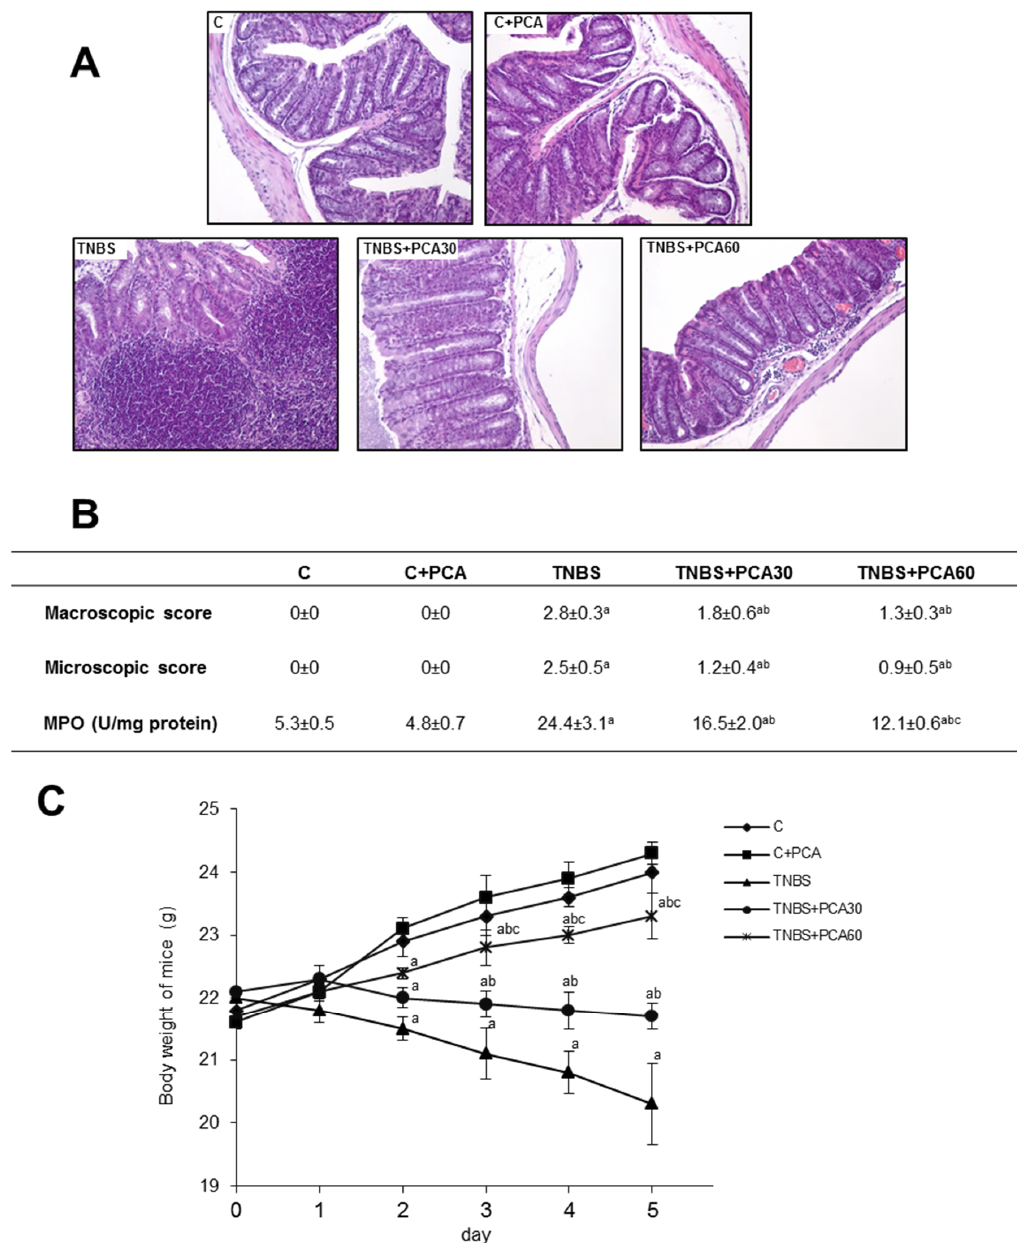
Figure 1. Effect of treatment with protocatechuic acid (PCA) on histological damage, macroscopic and microscopic scores, myeloperoxidase (MPO) activity and body weight in mice with 2,4,6-trinitrobenzenesulfonic acid (TNBS)-induced colitis. Representative sections of colonic tissue: control (C), C + PCA, TNBS, TNBS + PCA30 and TNBS + PCA60, stained with hematoxylin-eosin. Photographs are taken under magnification × 200. Ten non-overlapping randomly chosen fields of each section were scored ( A ). Macroscopic and microscopic scores and myeloperoxidase (MPO) activity ( B ), and body weight ( C ). Data are expressed as the means ± SEM of six mice per group. a p < 0.05 vs. C group; b p < 0.05 vs. TNBS group; c p < 0.05 vs. TNBS + PCA30 group.